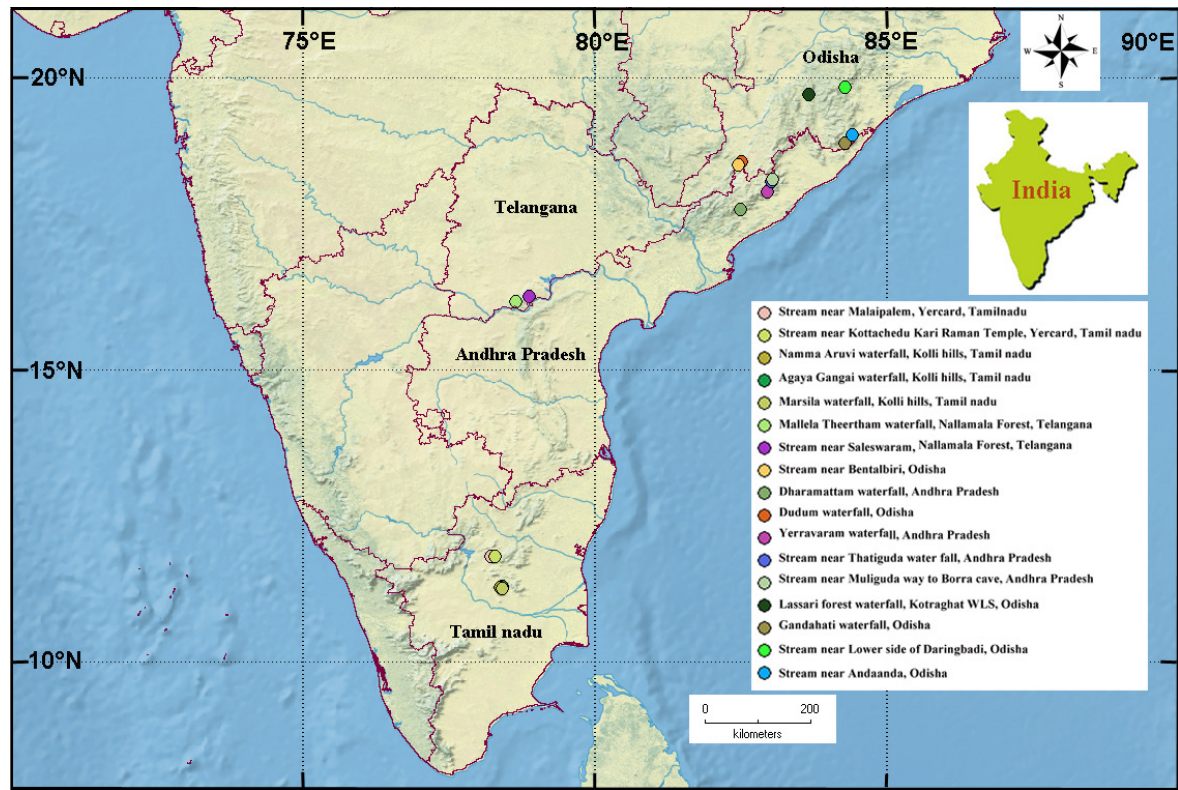
Figure 1. Distribution of Ptilomera agriodes from Eastern Ghats,